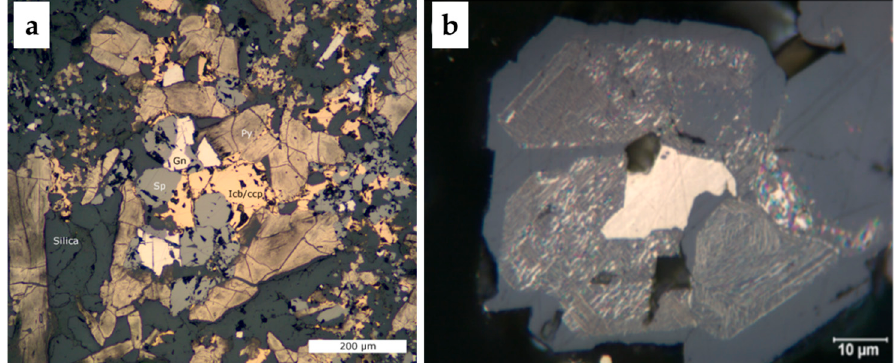
Figure 1. ( a ) Photomicrographs (under reflected light) demonstrating seafloor massive sulfides (SMS) mineralogy and texture, ( b ) sphalerite and isocubanite-chalcopyrite texture, sphalerite (grey) with strong chalcopyrite disease (yellow), the centre yellow grain is an intergrowth of isocubanite and chalcopyrite (after [8]). Abbreviations after [23]: Ccp—chalcopyrite, Sp—sphalerite, Gn—galena, Py— pyrite. Icb is isocubanite.